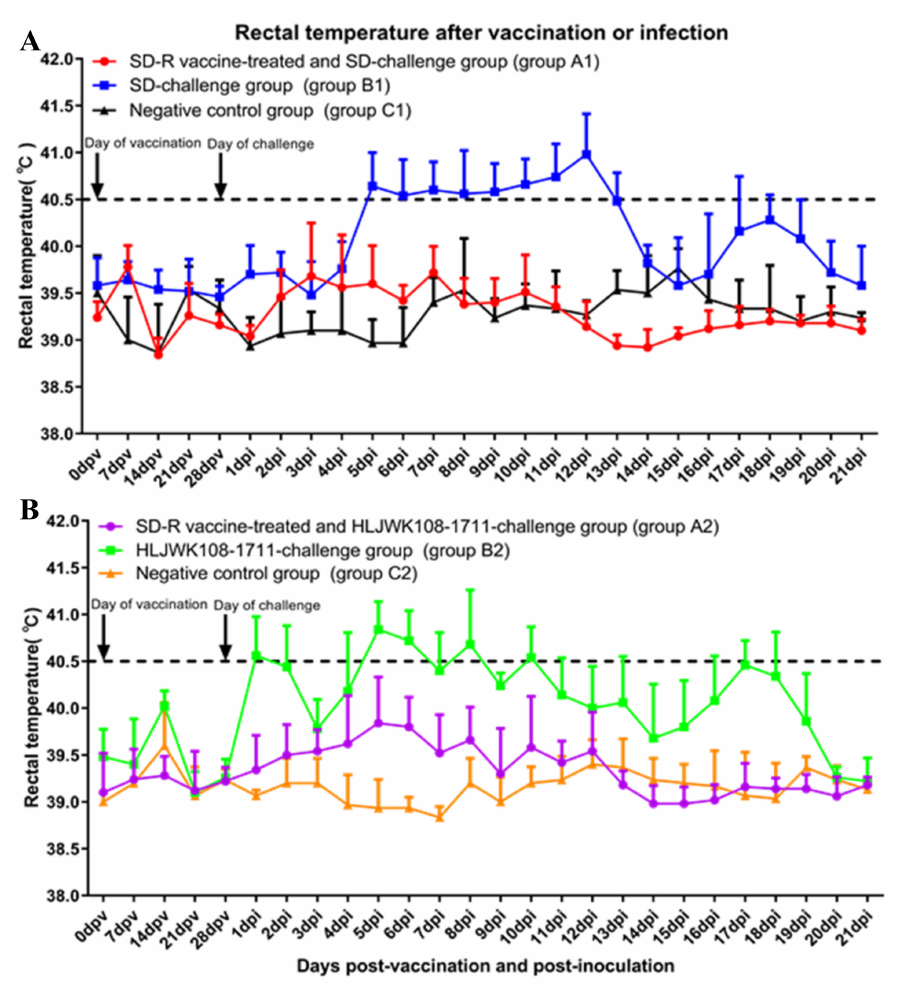
Figure 3. Rectal temperatures after SD-R immunization and challenge with parental virus SD ( A ) and NADC30-like PRRSV HLJWK108-1711 ( B ). Rectal temperatures ≥ 40.5 ◦ C were defined as fever. The group A1, B1 and C1 are labelled with red, blue, and black, respectively. The group A2, B2, and C2 are labelled with purple, green, and orange, respectively. The arrows mark the time of the immunization and